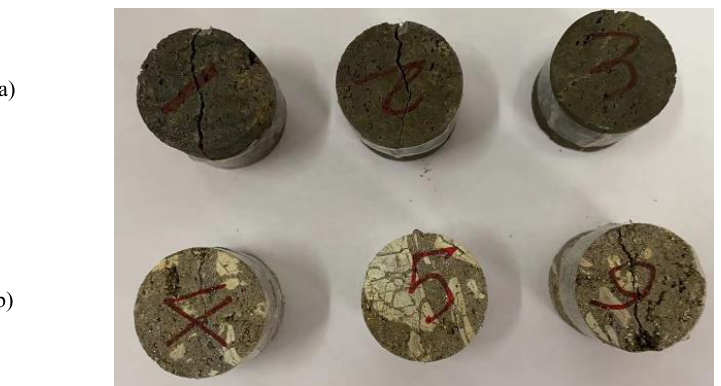
Figure 9. Brazilian splitting failure modes of two kinds of SMS samples. ( a ) Black; ( b ) White The peak strength and radial deformation of the two kinds of specimens are summa- rized in Table 2. We can see that the tensile strength of the black sample is higher than that of the white sample. Since the data of the No. 5 were eliminated, the average tensile strength of black and white samples are 3.84 MPa and 2.25 MPa, respectively. Table 2. Data of Brazilian splitting test. Number